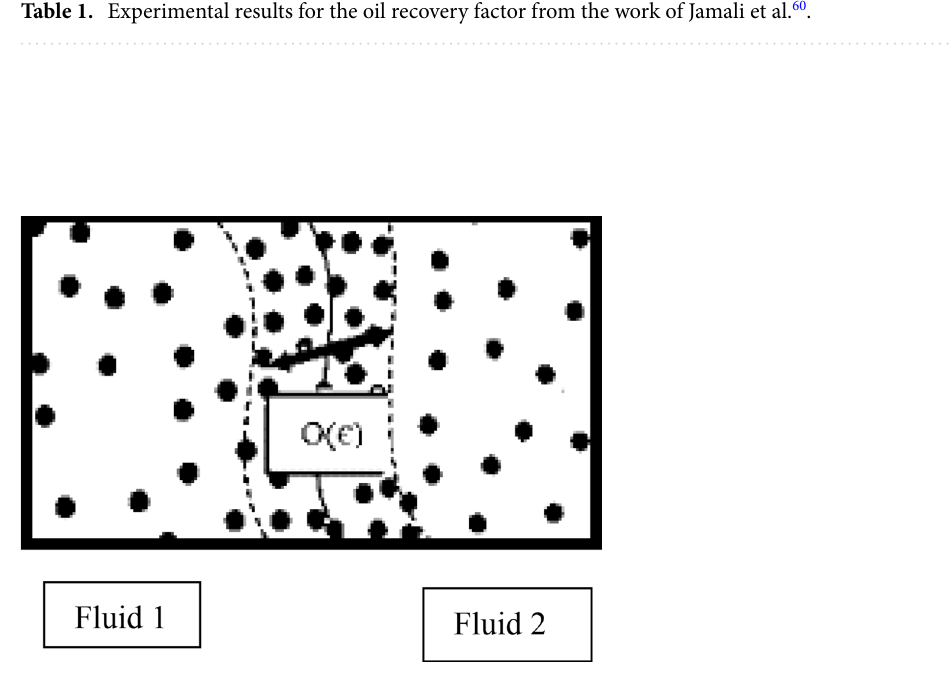
Table 1. Experimental results for the oil recovery factor from the work of Jamali et al. 60 .